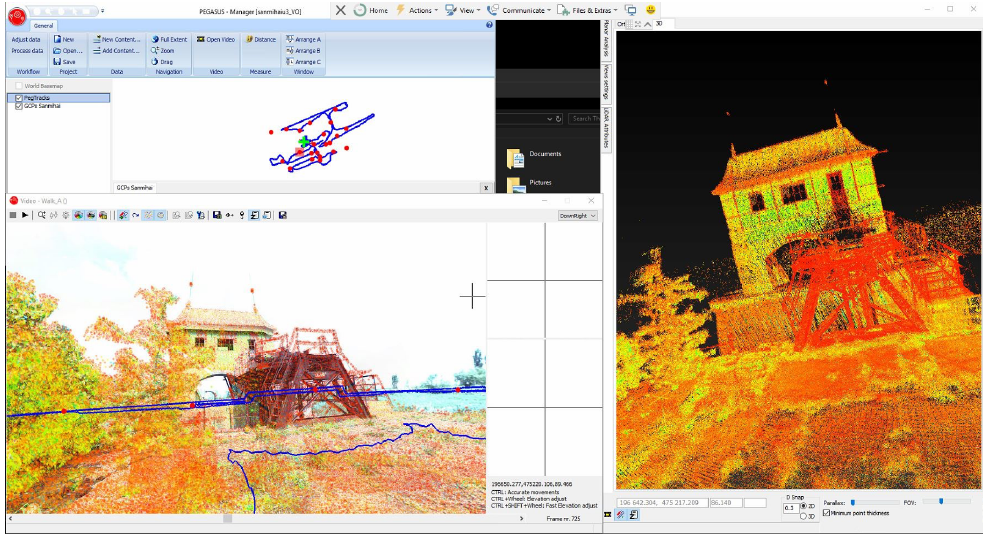
Figure 25. Presentation of LiDAR points over the video image and 3D presentation of LiDAR points.